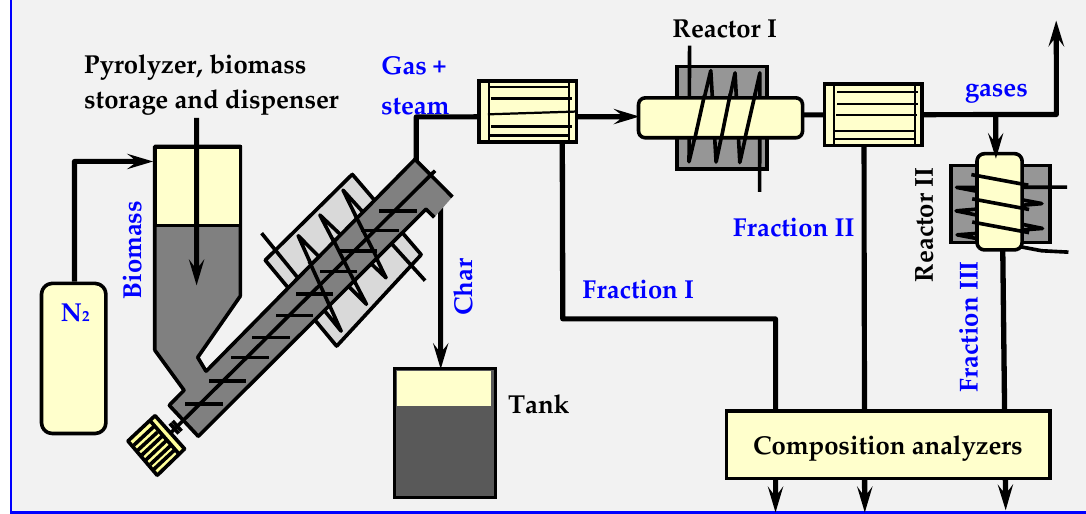
Figure 14. Diagram of the installation for testing the kinetics of biomass pyrolysis [17,94].